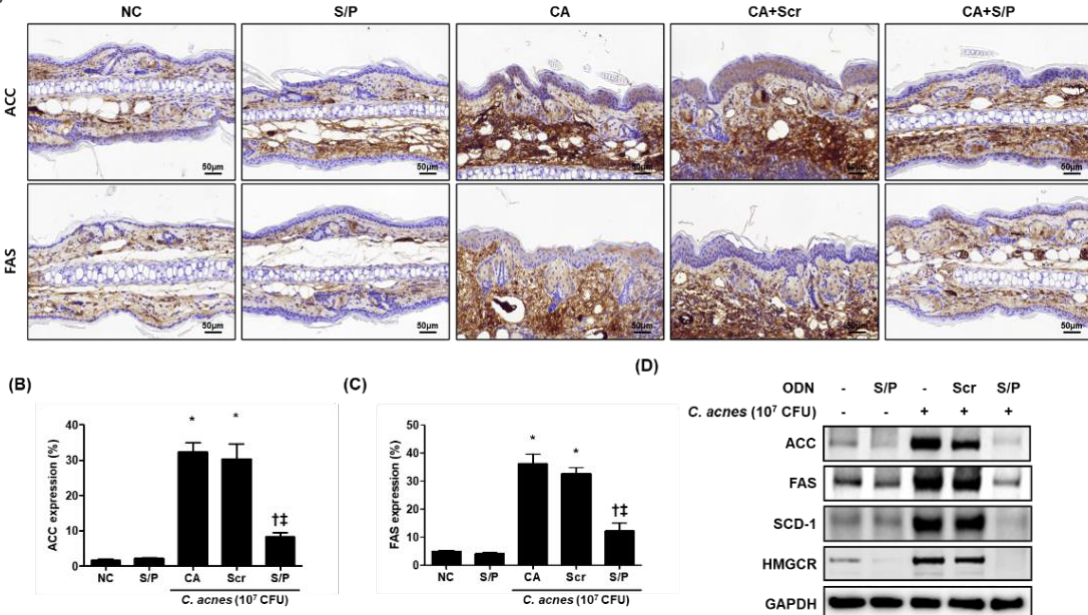
Figure 3. The SREBP/PPAR chimeric decoy ODN significantly inhibited fatty acid metabolism in the C. acnes -induced acne lesion mouse model. Representative images obtained from each group.